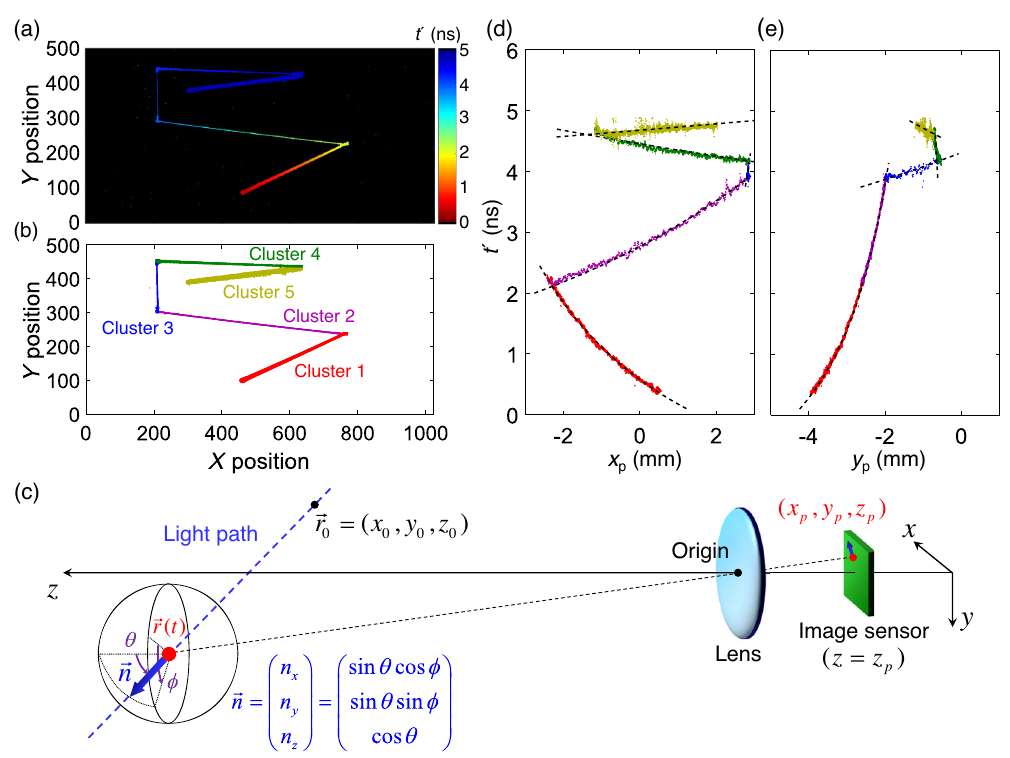
FIG. 3. Analysis of extracted spatiotemporal data set. (a) Color-coded plot of observation time for the light path. Red segments are observed earlier, and blue segments are observed later. Dark regions have no timing data. (b) Light path data subdivided into five data clusters of straight paths using 2D GMM fitting. (c) Schematic view of the coordinate system for light-in-flight reconstruction. The laser beam image is projected onto the focal plane by an objective lens in a flipped geometry. (d) Observation time t 0 as a function of x p , the x position on the focal plane. Each data cluster is individually fitted using a theoretical formula. Dashed lines are the fitting curves. (e) t 0 as a function of y p